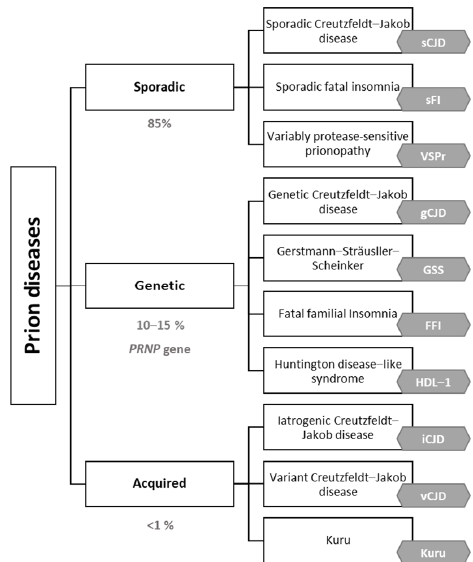
Figure 1. Prion diseases etiologic classification adapted by the authors [10–13].